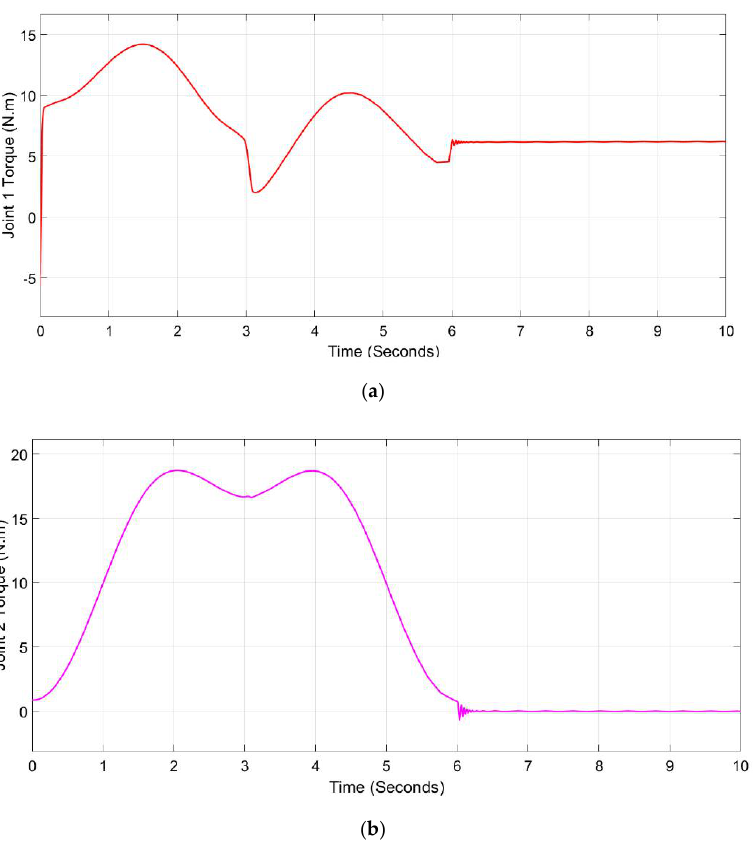
Figure 26. ( a ) Experimental torque responses of shoulder joint A/A ( θ 1 ); ( b ) Experimental torque responses of shoulder joint F/E ( θ 2 ).